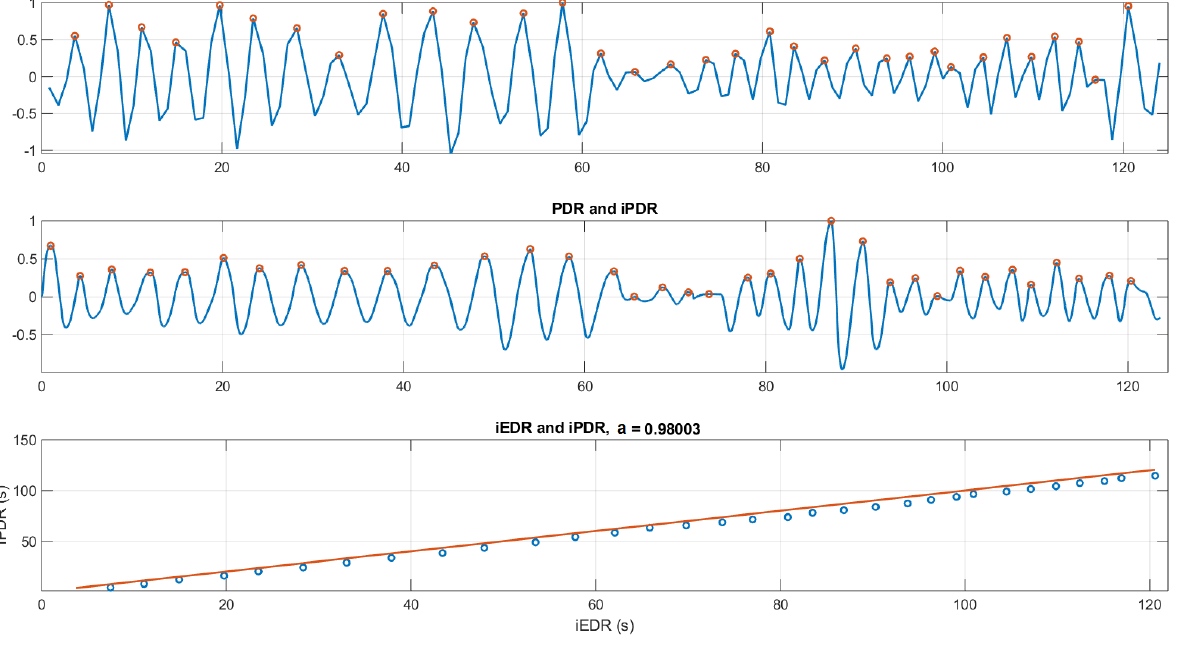
Figure 17. ( Top ): the EDR signal and its local maxima (peaks) iEDR . ( Middle ): the PDR signal and its local maxima iPDR . ( Bottom ): the linear regression fit line between iEDR and iPDR ( a =